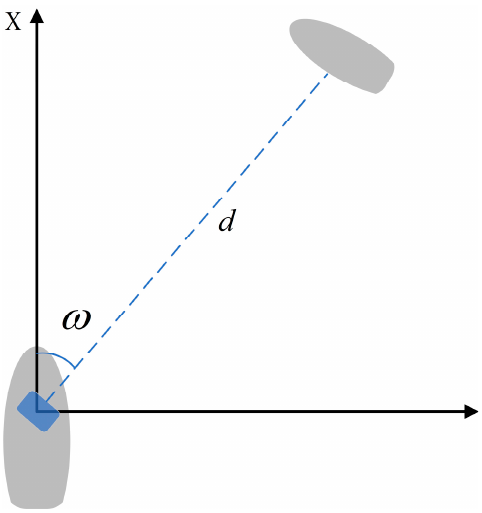
Figure 4. Relative position of the USV and the